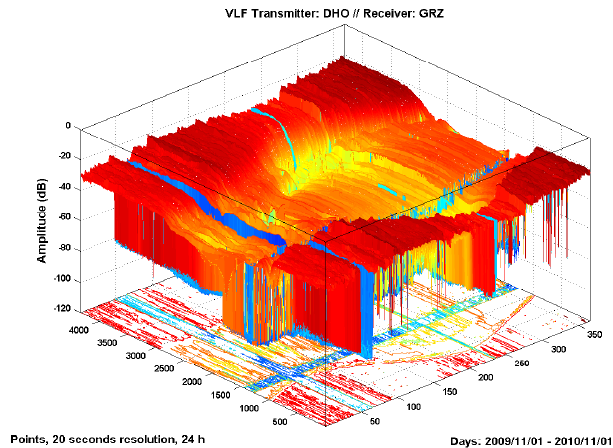
Fig. 2. VLF Amplitude data for one year – from 2009/11/01 to 2010/11/01 – between transmitter Rhauderfehn (DHO), Germany and receiver Graz (GRZ), Austria. Visible are (i) the two regular daily dips/cusps during sunrise/sunset, (ii) the noise floor during transmitter switch off, and (iii) an annual amplitude variation, espe- cially during nighttime, with higher amplitude values in winter that decrease in